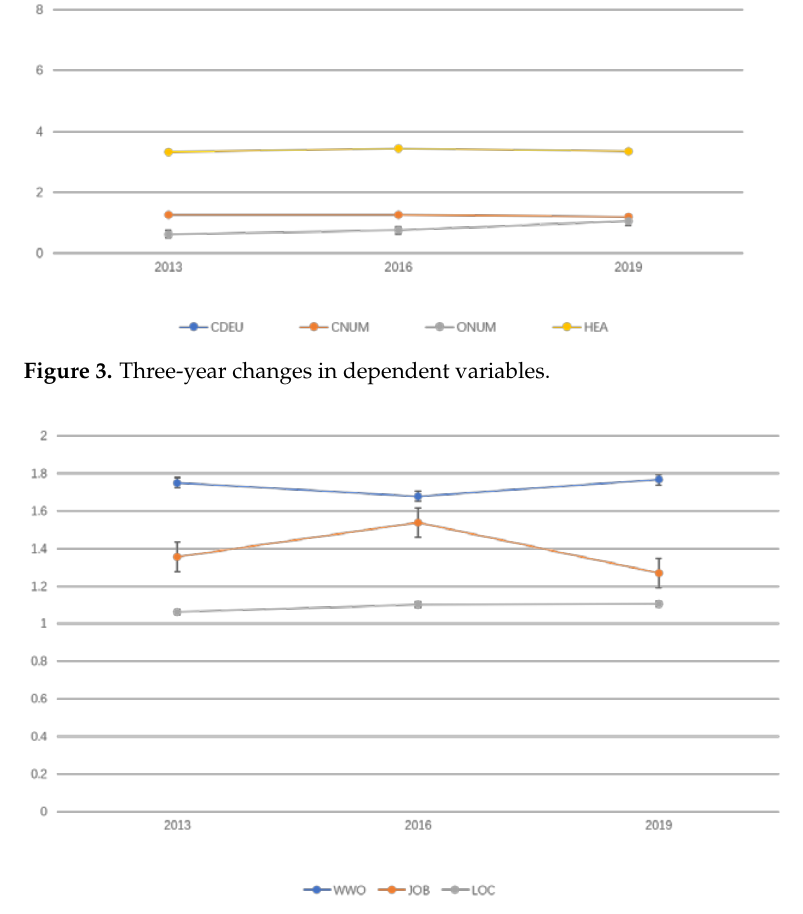
Figure 4. Three-year changes in employment transfer characteristics.